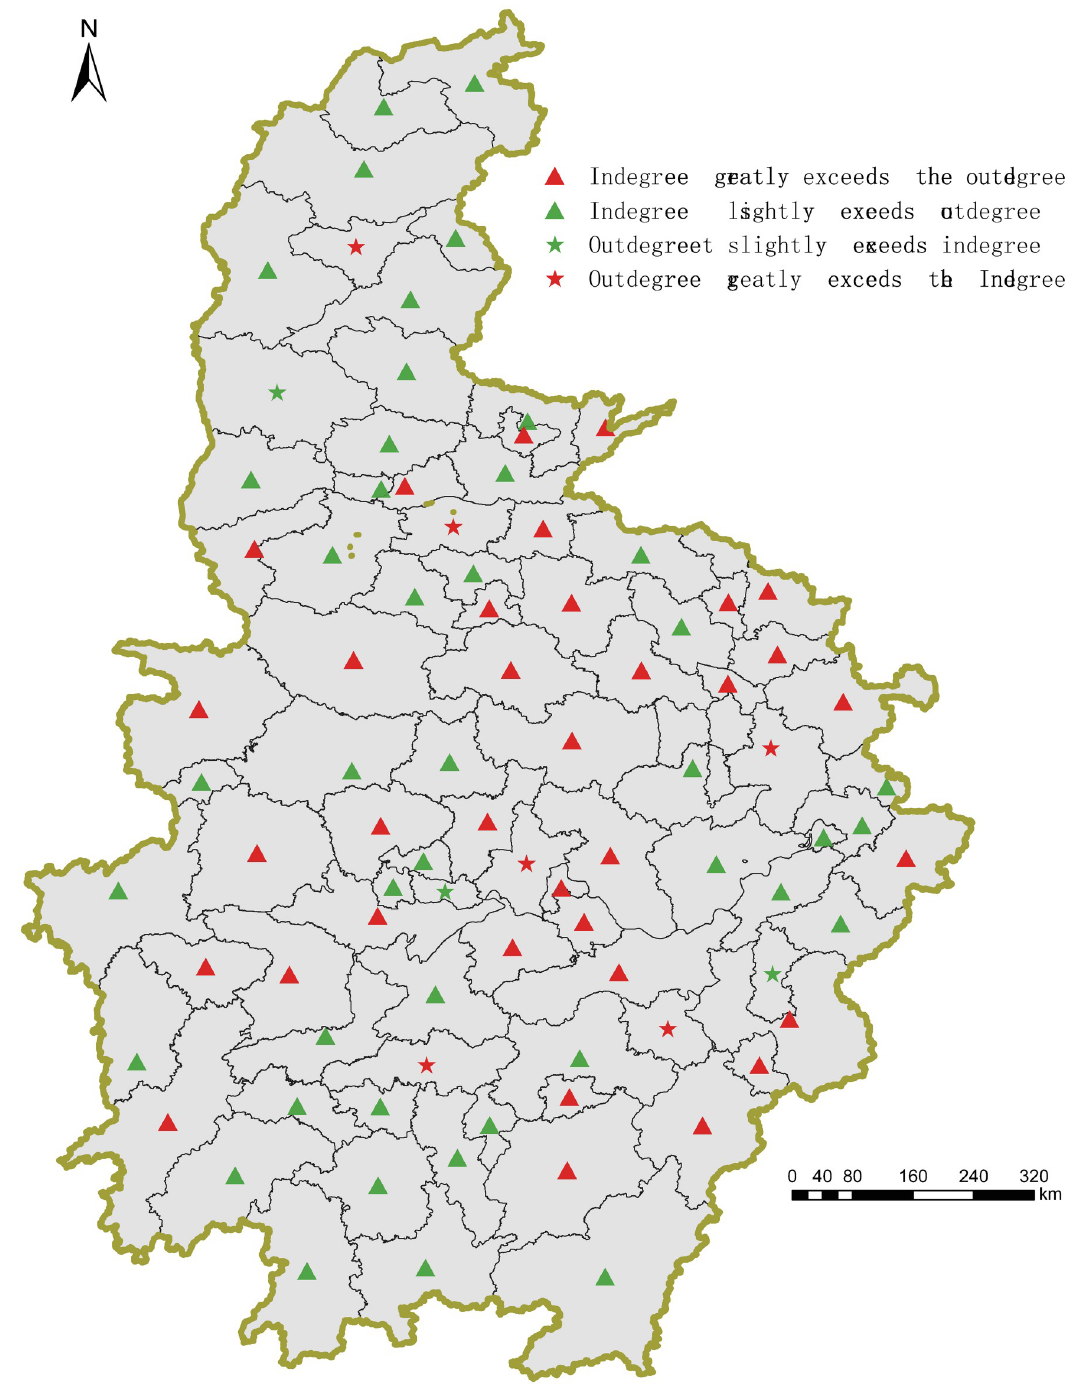
Fig 5. The differences in the spatial distribution of out-degree and in-degree values.